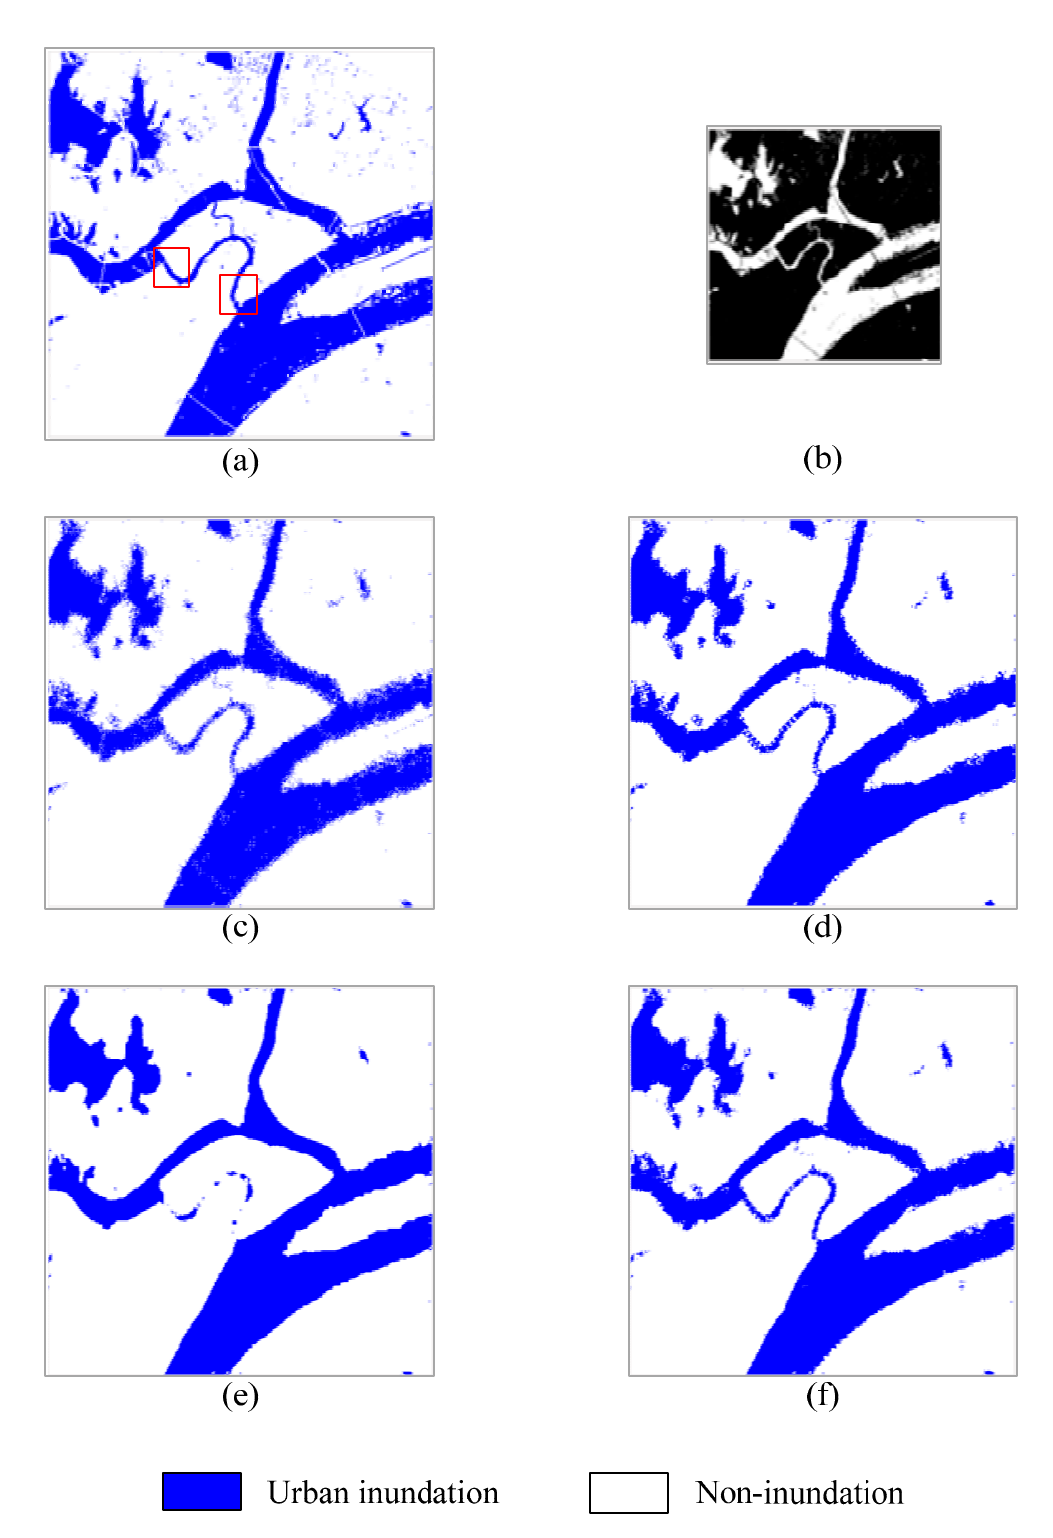
Figure 5. Experimental images and different SUIM results for Wuhan where red square shows the area for zooming. ( a ) Inundation reference image; ( b ) inundation fraction image; ( c ) back ‐ propagation neural network (BPNN) ‐ SUIM; ( d ) support vector machine (SVM) ‐ SUIM; ( e ) spatial attraction model (SAM) ‐ SUIM; ( f ) spatial attraction models and Elman neural networks (SAMENN) ‐ SUIM.